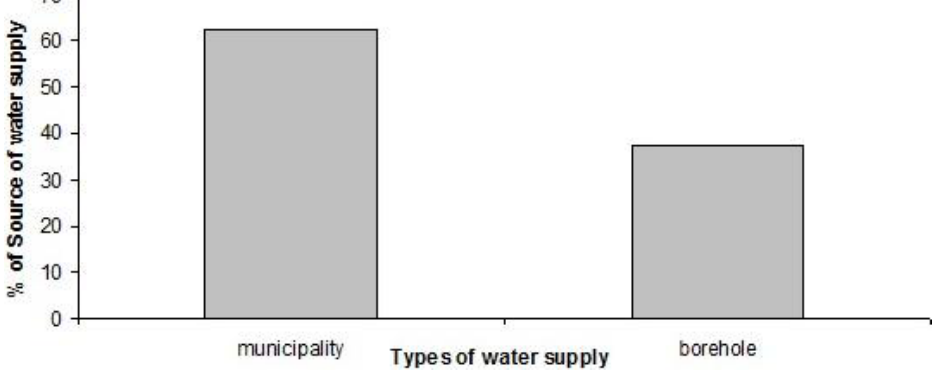
Figure 5. Sources of Water supply for